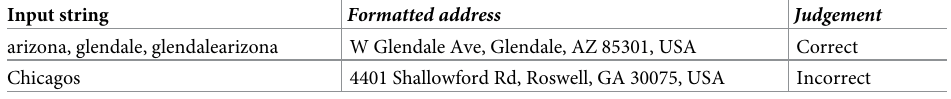
Table 3. Examples of Google Maps geocoding API formatted and geocoded address from provided input